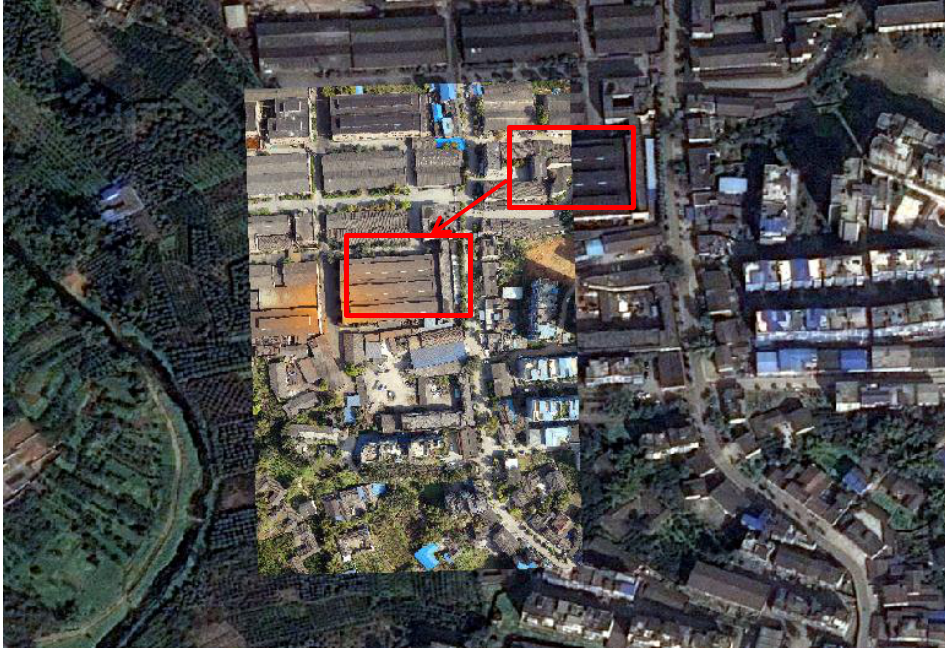
Figure 4. The georeferenced image overlaid on the google